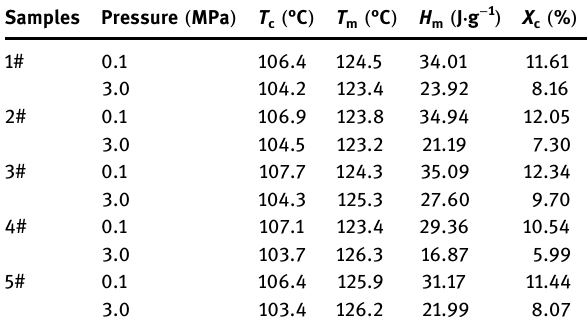
Table 1: Thermal property parameters of HDPE composites